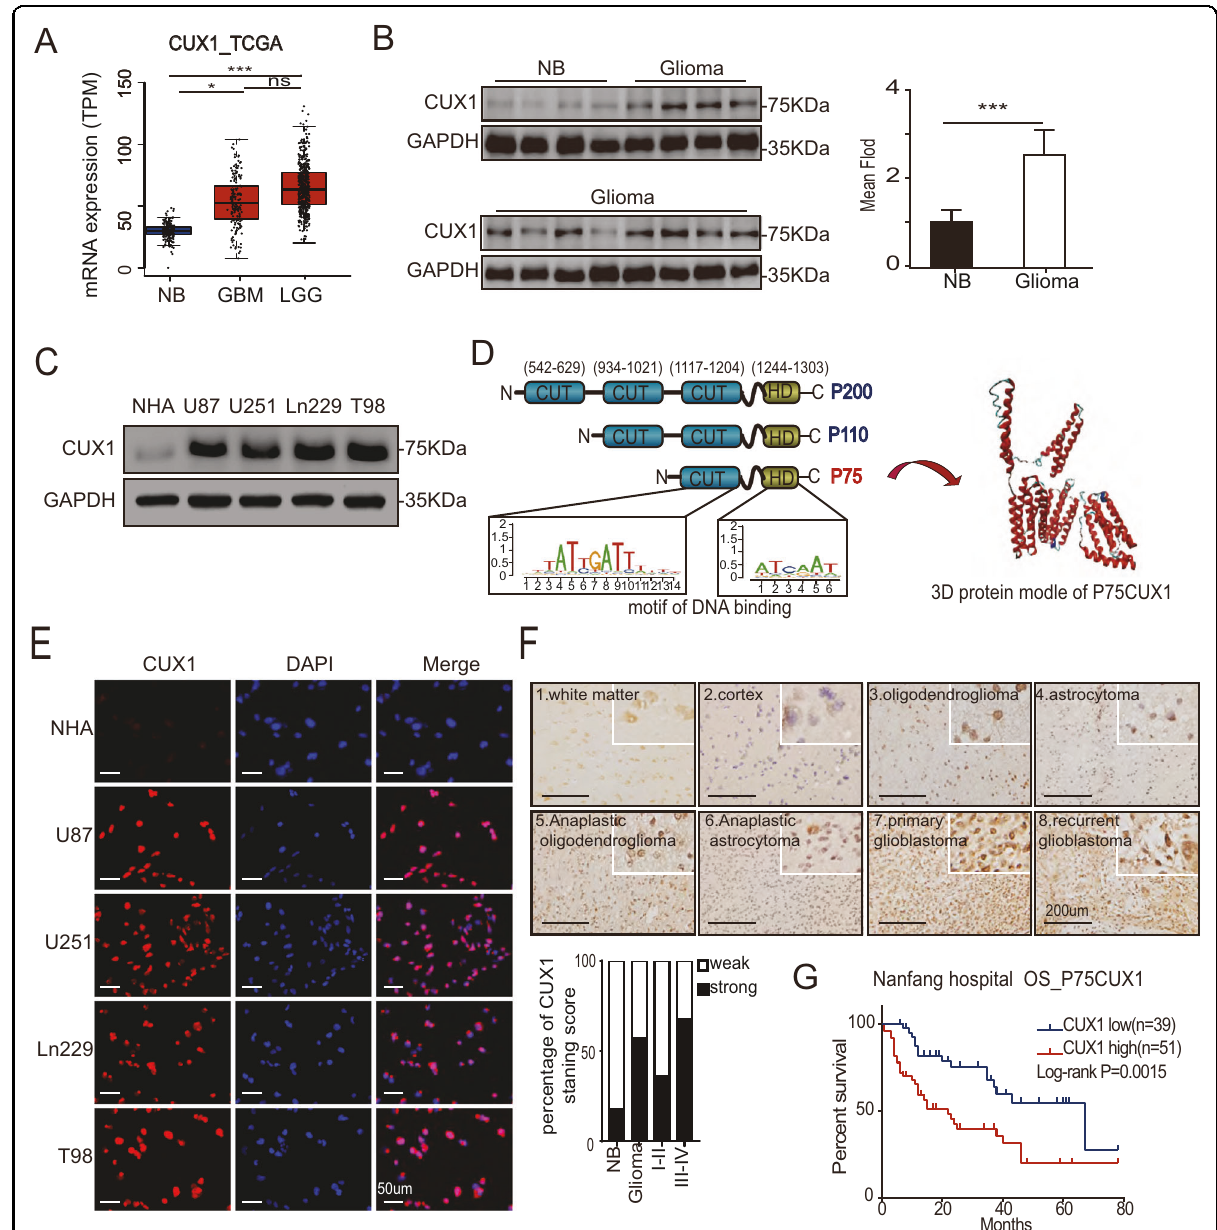
Fig. 1 P75CUX1 expression in NB and glioma cells. a The expression level of CUX1 mRNA was increased in glioma compared with NB tissues (GBM, n = 163; LGG, n = 518; NB, n = 207,). CUX1 mRNA expression data was derived from RNA sequencing array of TCGA and GTEx databases, analyzed with the GEPIA webserver (* P < 0.05, ***: P < 0.001). b P75CUX1 protein expression was evaluated in 12 glioma tissue samples compared with four normal tissue samples with WB assay (***: P < 0.001). c P75CUX1 protein expression of CUX1 in normal glial cell and glioma cell lines was examined with WB assay. d Domain Organization of P75CUX1 and function of the Domains. CUT CUT domain, HD Homeobox DNA-binding domain and the CUT domain is DNA-binding and protein-interacting motif, which can bind independently or in cooperation with the homeodomain. And HD domain binds DNA through a helix-turn-helix type of structure. The motif of binding DNA in the domain was analyzed with Cristome. 3D model of protein was designed with I-TASSER (C-score = − 0.79, Estimated TM-score = 0.61 ± 0.14). e P75CUX1 expression and localization of CUX1 in normal glial cell lines and glioma cell lines were examined by IF assay. f P75CUX1 expression in NB tissues and glioma was examined by IHC staining (NB, n = 90; glioma, n = 22), including normal white matter (1), normal cortex (2), oligodendroglioma (grade-II) (3), astrocytoma (grade-II) (4), anaplastic oligodendroglioma (grade-III) (5), anaplastic astrocytoma (grade-III) (6), primary glioblastoma (grade-IV) (7), and recurrent glioblastoma (grade-IV) (8). g Kaplan – Meier survival analysis for overall survival of patients with glioma based on protein expression of P75CUX1 (90 glioma samples were collected from Nanfang hospital, P =